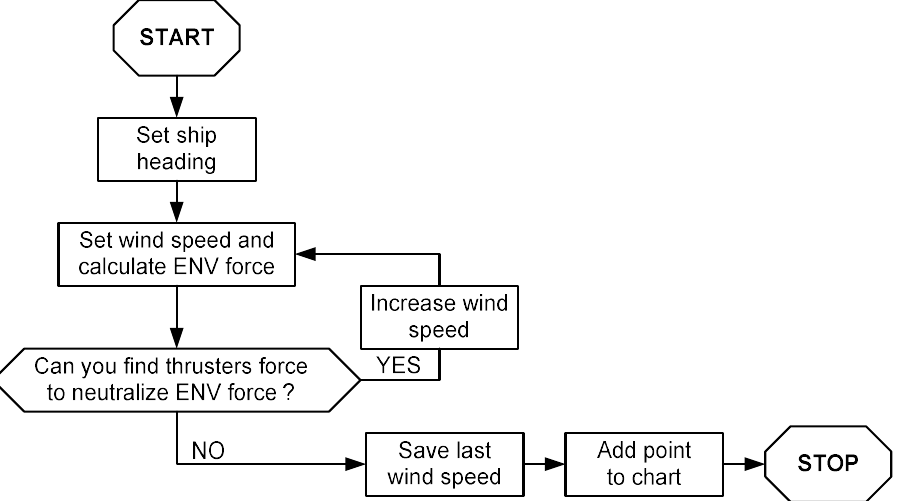
Figure 2. Algorithm for plotting the ability to hold a position.